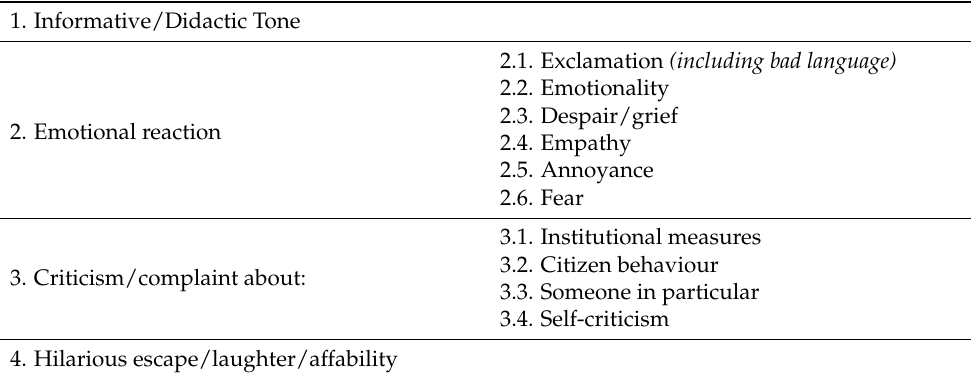
Table 2. Codebook for the analysis of expressive